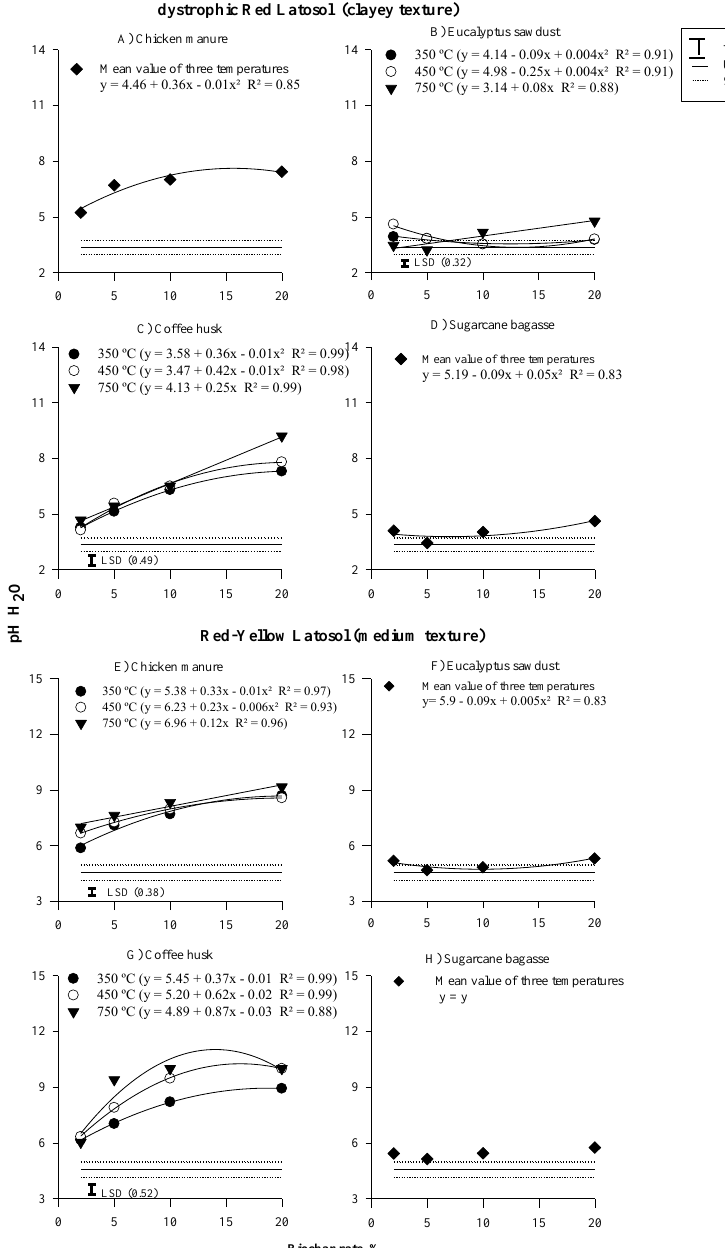
Figure 3. The pH of the dystrophic Red Latosol (clayey texture) and Red-Yellow Latosol (medium texture) as a function of biochar rates of chicken manure (A, E), eucalyptus sawdust (B, F), coffee husk (C, G) and sugarcane bagasse (D, H), pyrolyzed under different temperatures, after 9 months of incubation. Tukey’s Least Significant Difference (LSD) ( p < 0.05).